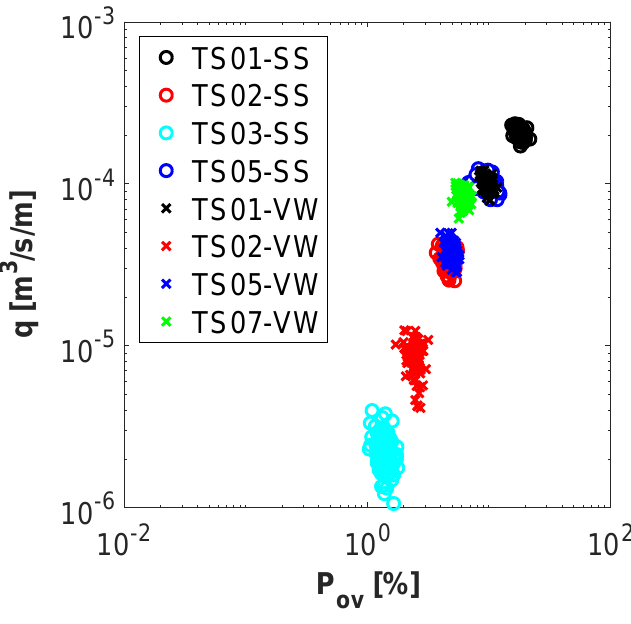
Figure 8. Graph showing P ov plotted against q for random seeding test with both